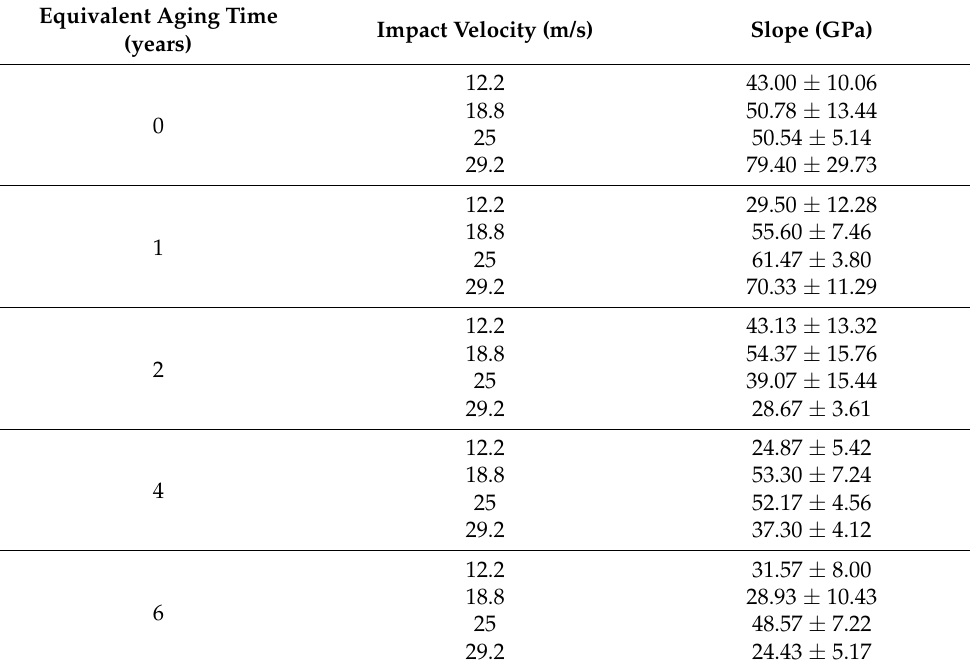
Table 3. The slope of the compression stress-strain curves under different impact velocity and equivalent aging time.